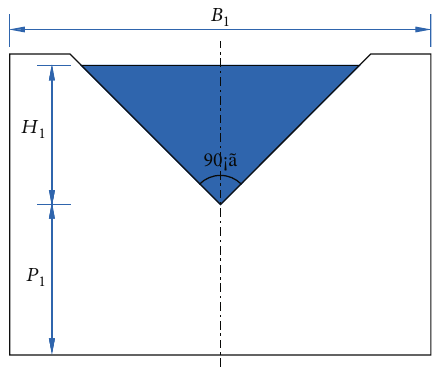
Figure 3: Illustration of the thin-walled right triangular weir